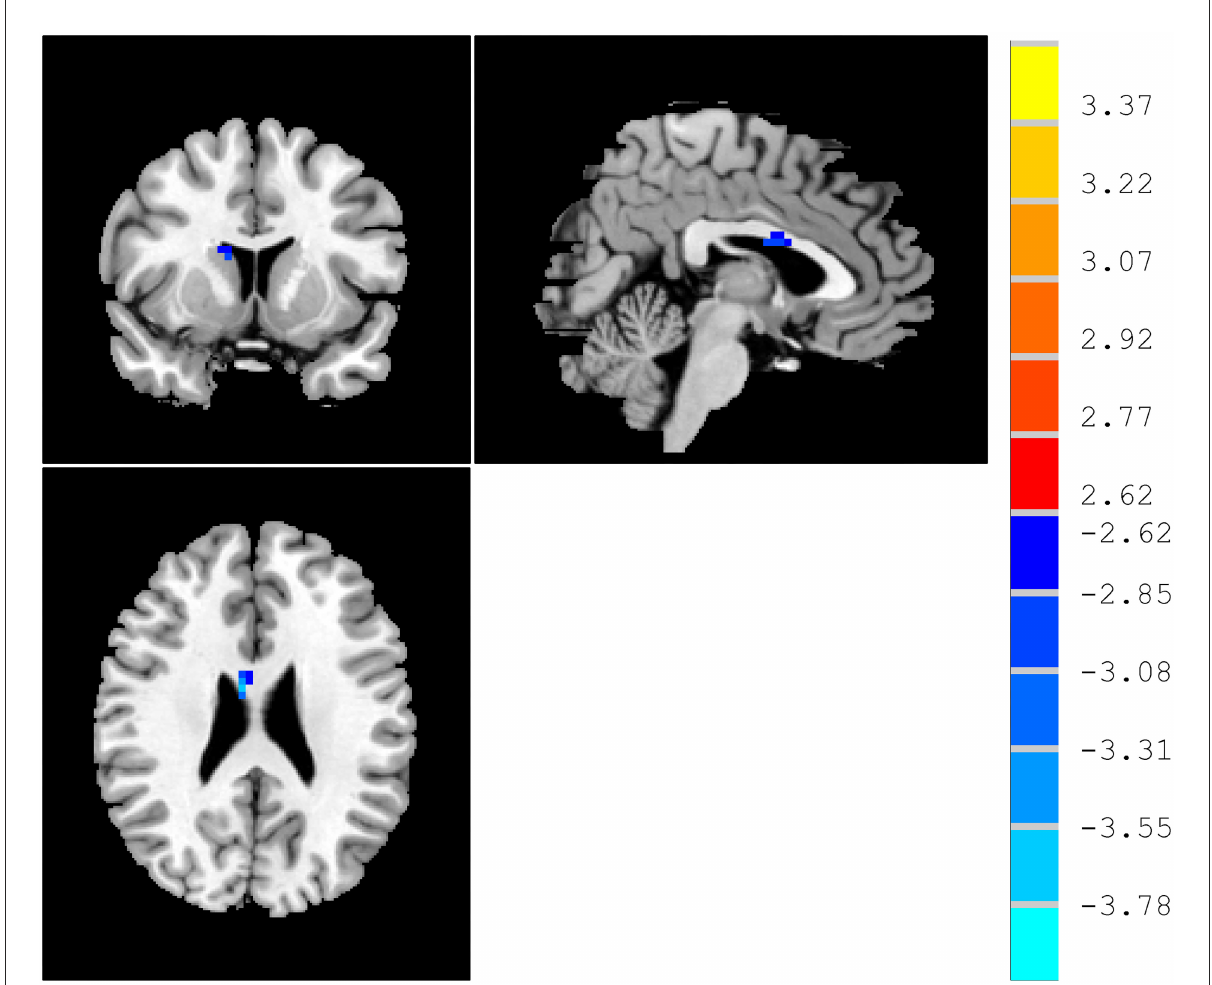
FIGURE1 ReHo differences between patients with MCI and HCs. Red and blue denote higher and lower ReHo, respectively, and the color bars represent the t- values from the t -test of the group analysis. ReHo, regional homogeneity; MCI, mild cognitive impairment; HCs, healthy